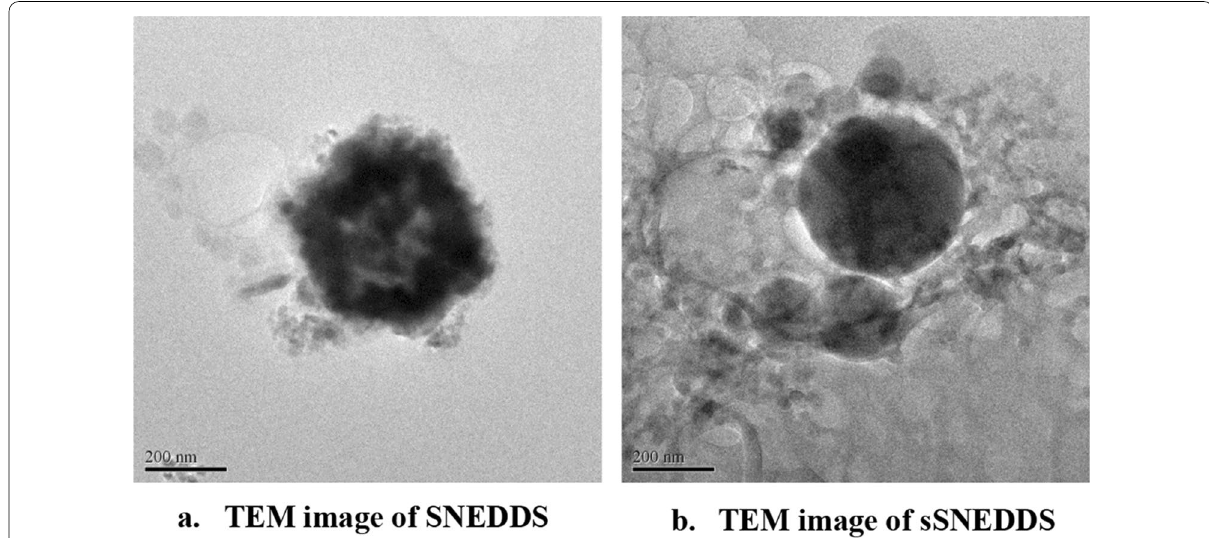
Fig.9 TEM images of Pemigatinib loaded SNEDDS AND sSNEDDS